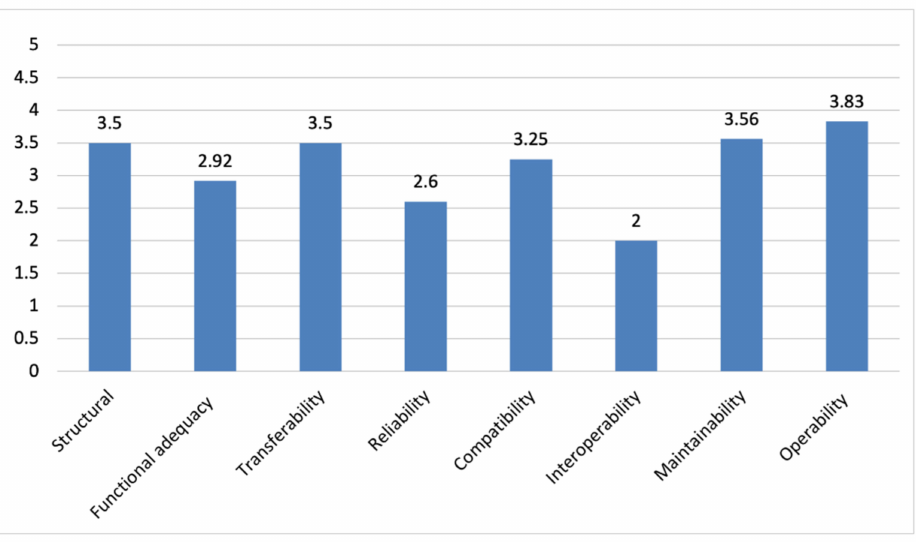
Figure 2. Quality of the CIDOC CRM according to the improved evaluation with application of new metrics for